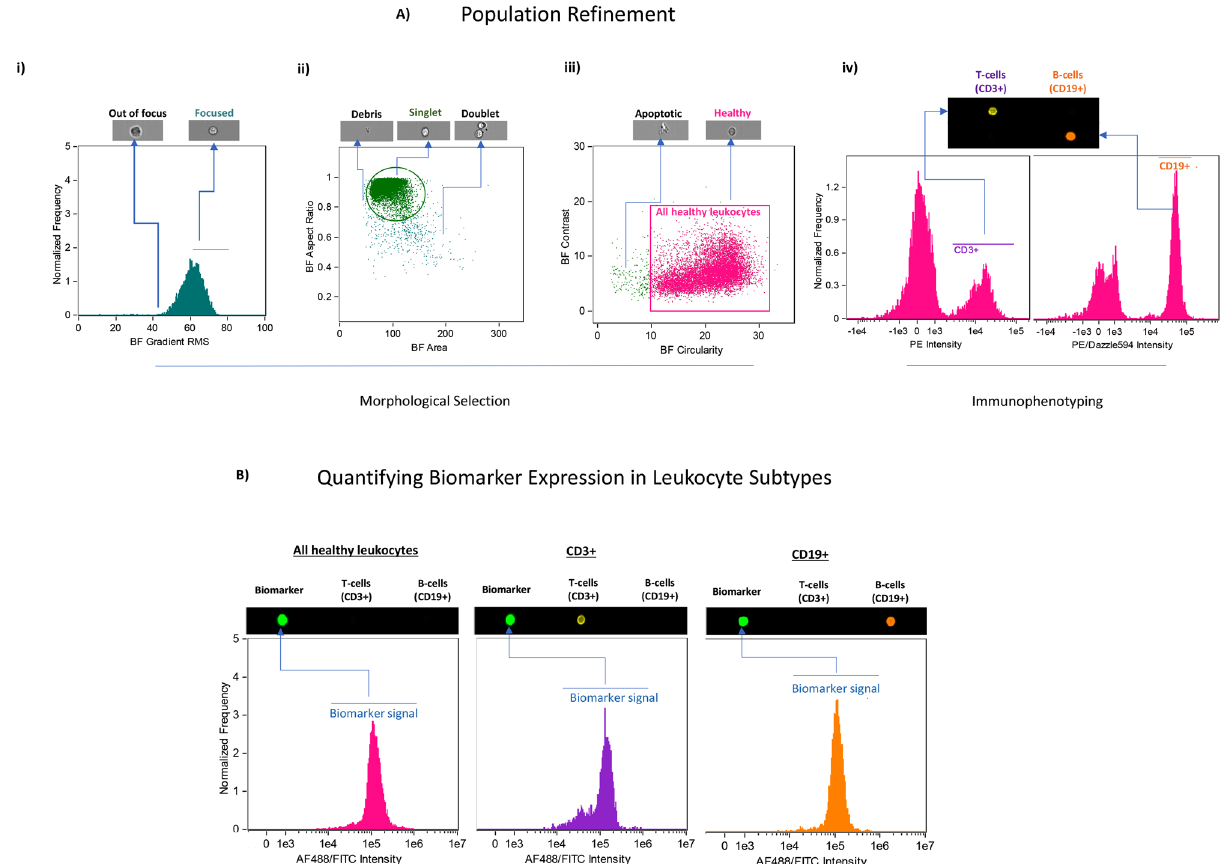
Figure 1. Representative example of our approach for analysis of imaging flow cytometry images and spectral data using IDEAS software. ( A ) Population Refinement. The template first gates for focused, single, healthy cells in T and B populations as follows: (Ai) to select only focused cells for analysis, images of cells were visually inspected, and a relevant region was set on the brightfield (BF) Gradient root mean square (RMS) feature. (Aii) Single cells (singlets) were selected by creating a gate in a bivariate plot of BF Aspect Ratio versus BF Area. (Aiii) Healthy cells were selected by creating a gate in bivariate plot of BF Circularity versus BF Contrast, thus excluding apoptotic cells. (Aiv) B and T cell populations were selected using regions for CD19 + and CD3 + signals, respectively. ( B ) Quantifying Biomarker Expression in Leukocyte Subtypes. The mean fluorescence intensity (MFI) of each biomarker signal within all healthy leukocytes, CD3 + , and CD19 + cell populations was then computed by the IDEAS software. This analysis template was applied to all data files and automatically batch processed within